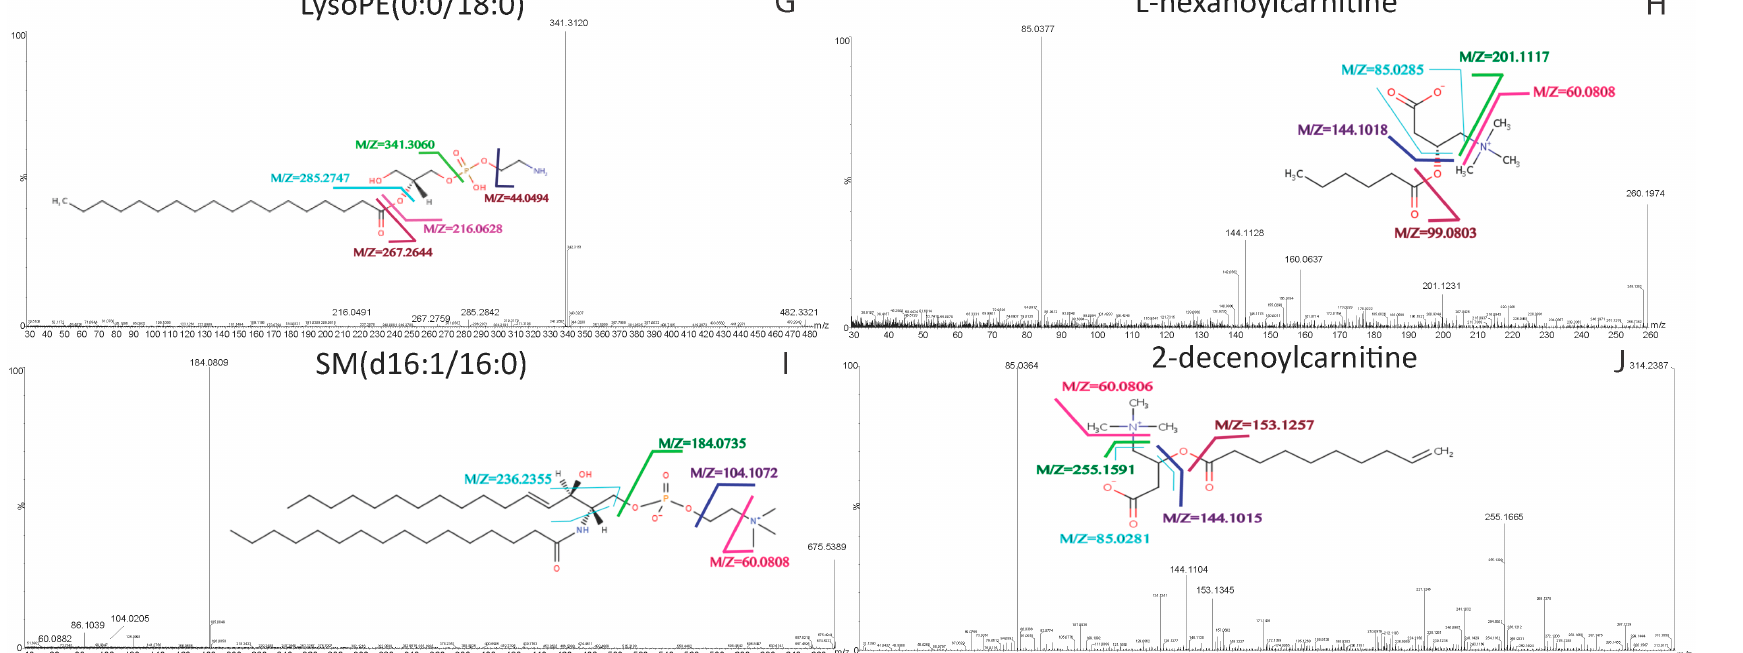
Figure 3. Cont. Figure 3.